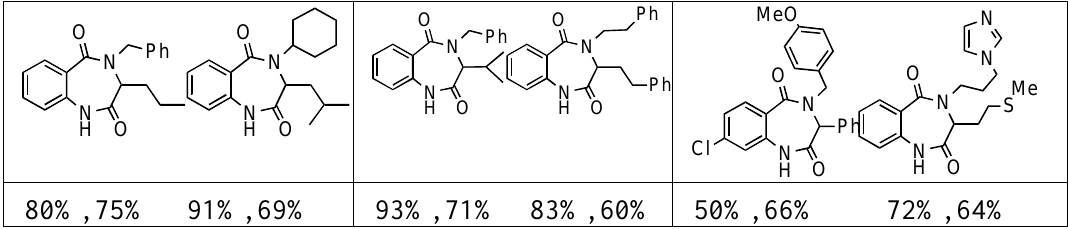
Table 2. The Ugi-DC 1,4-benzodiazepine-2,5-dione products and yields (2